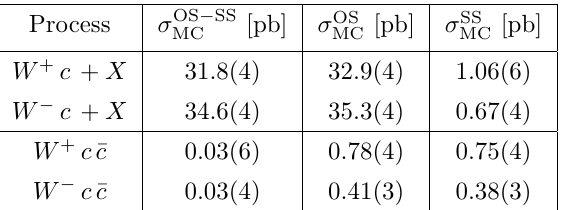
Table 8 . Same as table 6, but for W ± + j c ( j ¯ c ) production according to the analysis of ref. [21], with PYTHIA8 configured according to the ATLAS A14 central